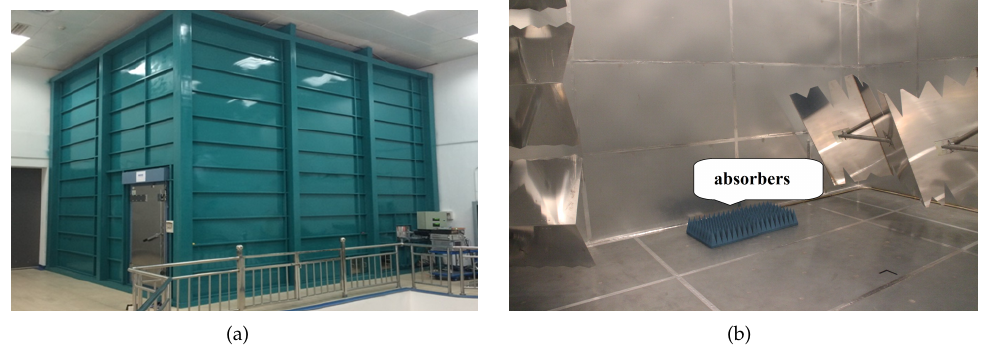
Figure 8. NIM (National Institute of Metrology) RC (reverberation chamber). ( a ) appearance of the NIM RC; ( b ) absorbers in the NIM